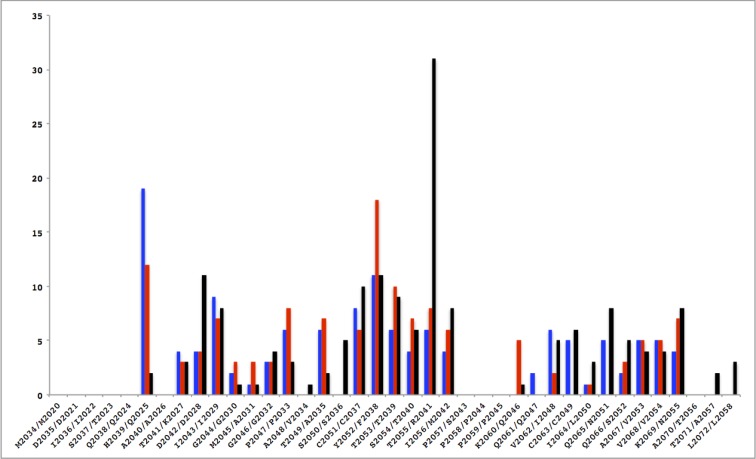
Comparison of contacts between AMA1 and the RON2 peptide in the homo- and hetero-complexes.The number of interatomic contacts < 3.8 Å (ordinate) is given as a function of the RON2 sequence (abscissa; PvRON2/PfRON2). In the histogram, the PvAMA1-PvRON2sp1 complex is shown in blue, the PfAMA1(FVO)-PvRON2sp1 complex is in red and the PfAMA1(3D7)-PfRON2sp1 complex [10] is in black.